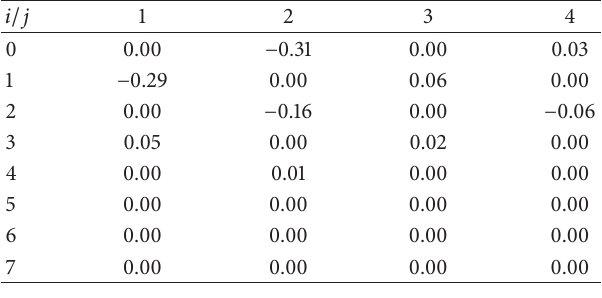
= 180 to 𝑡 = 1.5 . aL